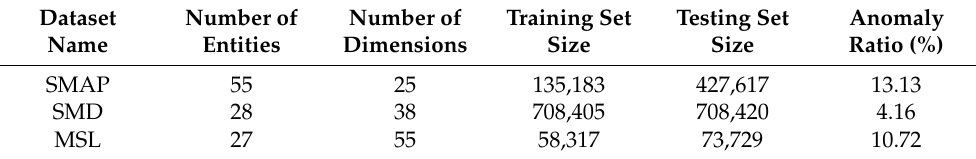
Table 1. Dataset